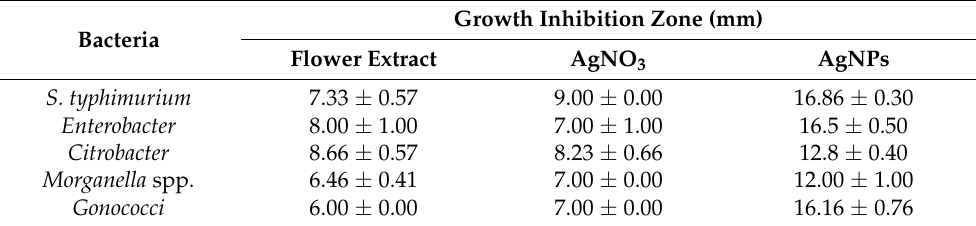
Table 2. Bacterial Growth Inhibition Potential of Biosynthesized AgNPs from C. guianensis Flower Extract. Bacteria